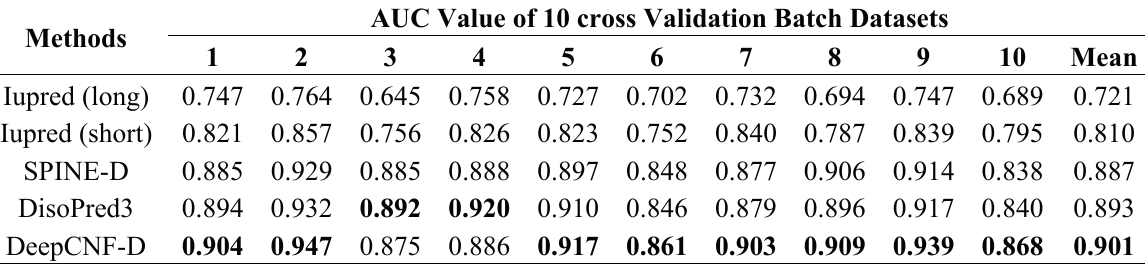
Table 5. AUC value of several methods on 10 cross validation batch datasets of Disorder723.